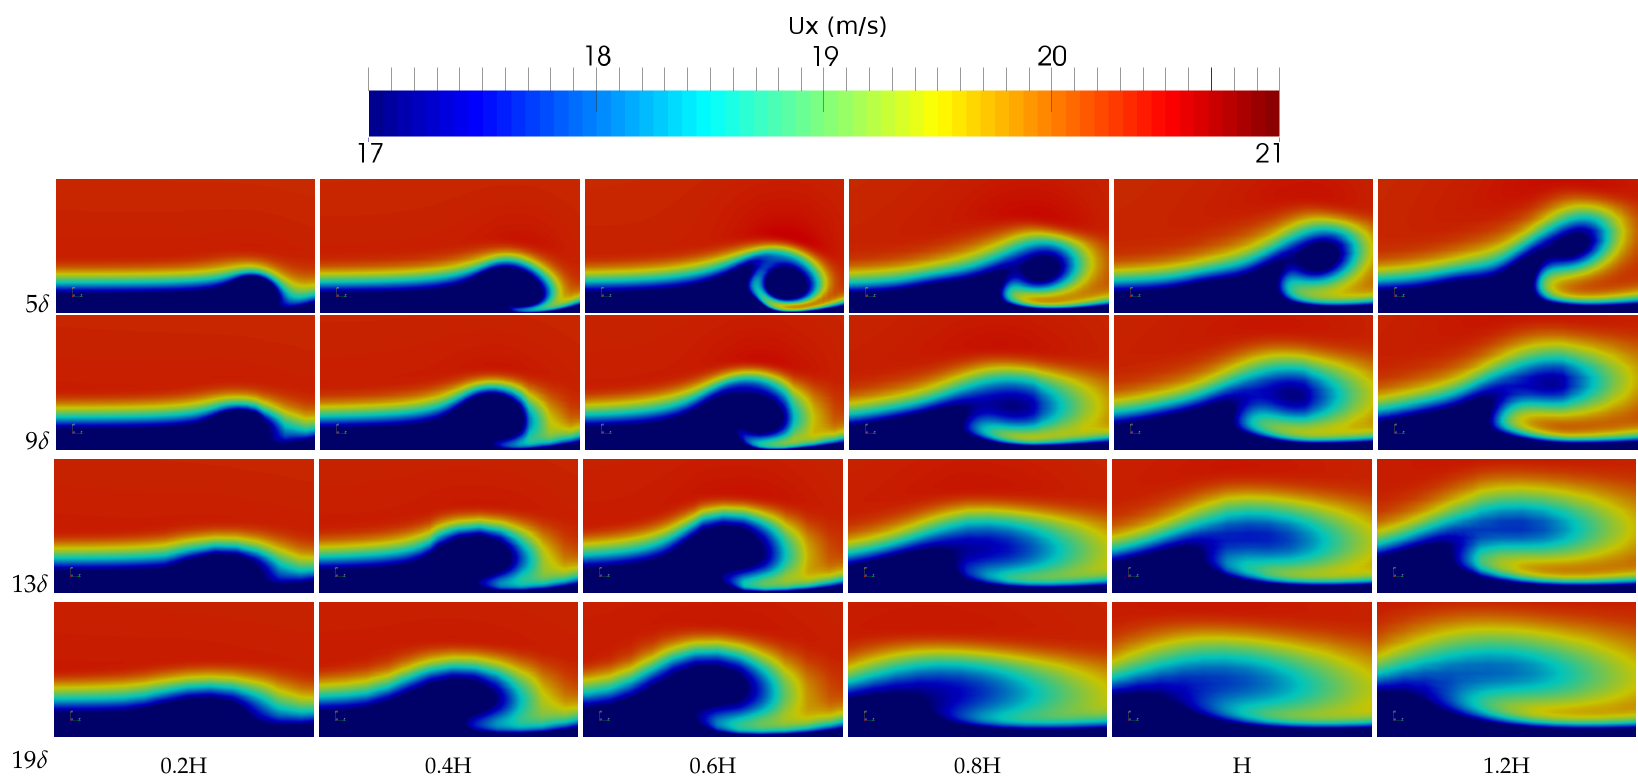
Figure A4. Axial velocity distributions Ux ms − 1 at four different planes normal to the streamwise direction and located at distances proportional to the local boundary layer thickness δ from the edge shown for six vortex generator heights (0.2H, 0.4H, 0.6H, 0.8H, H and 1.2H). Incident angle of β = 20 ◦